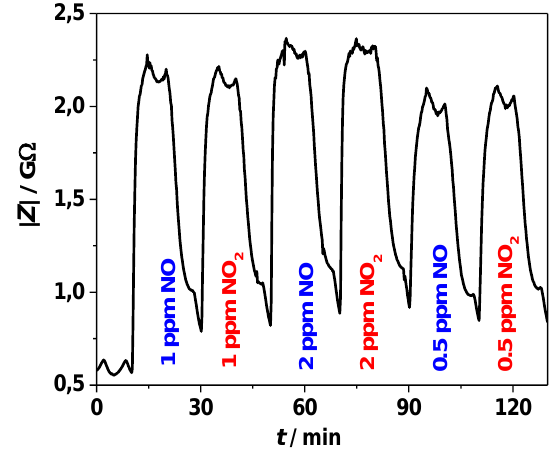
Figure 3. Complex impedance | Z | signal of the SnS 2 sensor determined at f = 1 Hz at 130 °C during NO x exposure to 1 ppm, 2 ppm and 0.5 ppm NO res. NO 2.